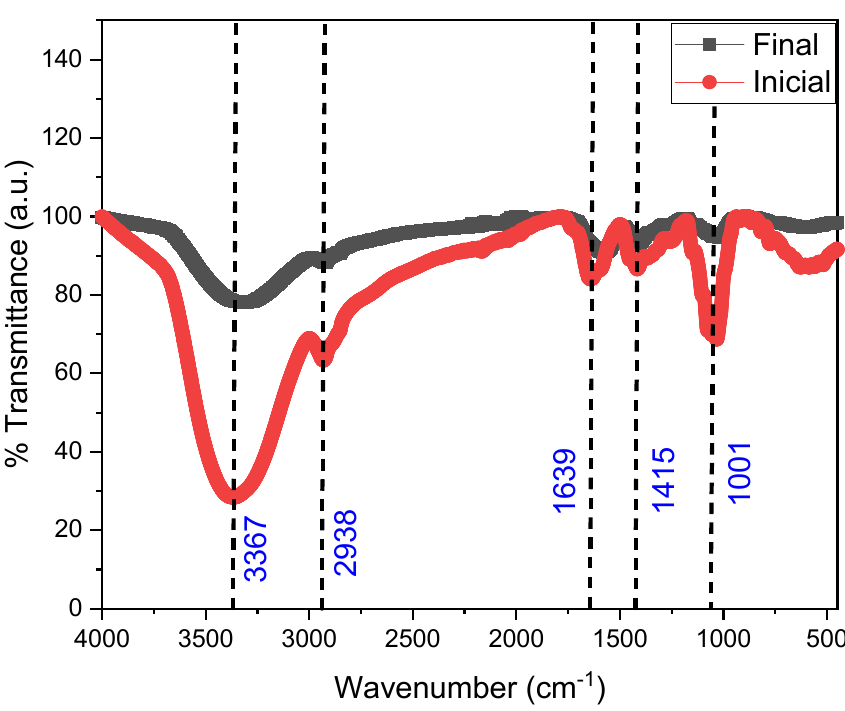
Figure 5. FTIR spectra of banana waste in its initial and final state. Molecular identification of bacteria was achieved by sequencing a PCR product specific to the 16S bacterial ribosomal gene region [41]. They were analyzed by the BLAST program which obtained 100% of identity for the species Pseudomonas aeruginosa , 99.09% for the species Paenalcaligenes suwonensis , 99.39% for the species Klebsiella oxytoca , and 99.8% for the species Raoultella terrigena (Table 1). Table 1. BLAST characterization of the rDNA sequence of bacteria isolated from the MFC anode plate with banana juice substrates .